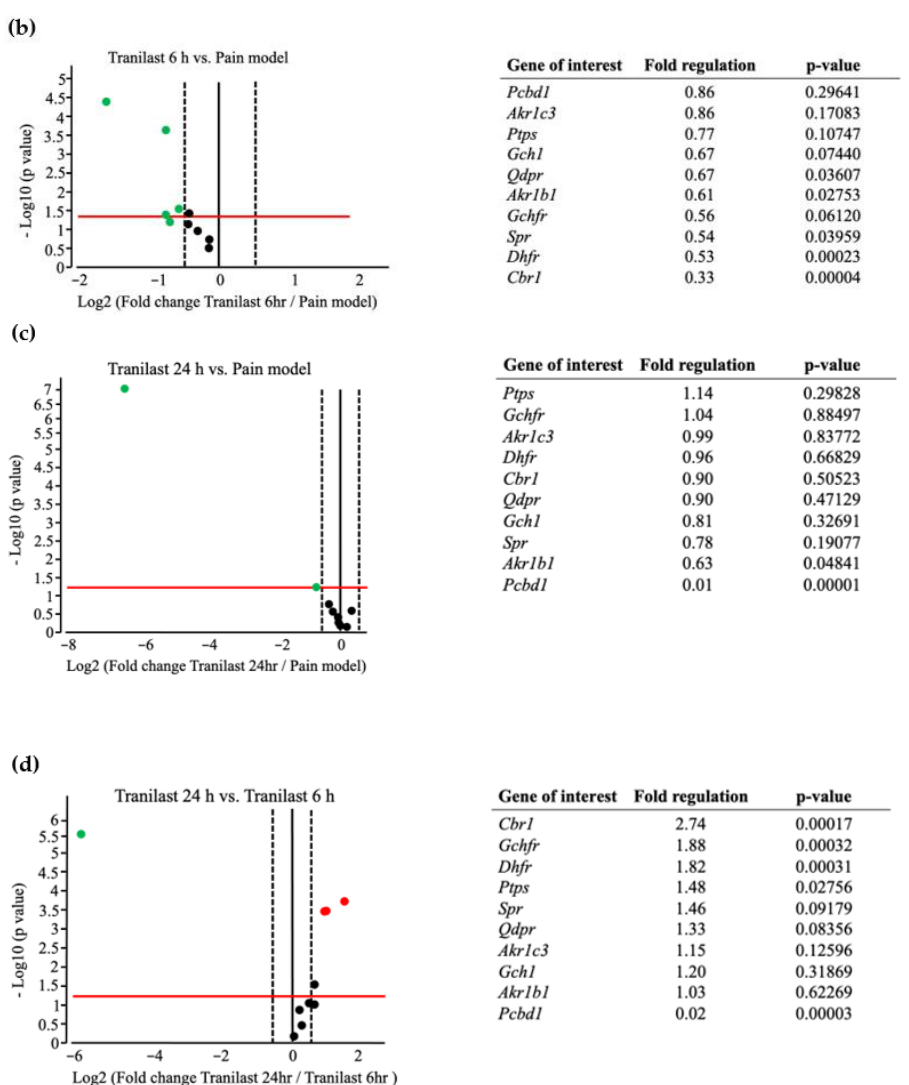
Figure 7. Fold regulation of genes involved in the BH4 pathway from the RT 2 profiler PCR array data, represented as a volcano plot. The red horizontal line represents p = 0.05, the points above are indicative of p < 0.05, and the points below are indicative of p > 0.05. The black vertical lines represent the log2 fold change threshold of − 0.5/0.5 respectively, with no change indicated by the middle line. Red, black, and green dots indicate upregulated, no change and downregulated genes, respectively. The dots above the red line indicate a greater than 1.5-fold change (x-axis) and p < 0.05 (y-axis). The fold regulation and p -values are listed beside each volcano plot. ( a ) Volcano plot between the pain model (infraorbital nerve constriction (IONC) + no treatment) and the control group. ( b ) Volcano plot between the tranilast-treated group after 6 h (IONC + tranilast treatment) and the pain model (IONC + no treatment). ( c ) Volcano plot between the tranilast-treated group after 24 h (IONC + tranilast treatment) and the pain model (IONC + no treatment). ( d ) Volcano plot between the tranilast-treated group after 24 h and 6 h (IONC+ tranilast treatment). Fold regulation cut off: 1.5; p -value cut off = 0.05; n = 6 per group.